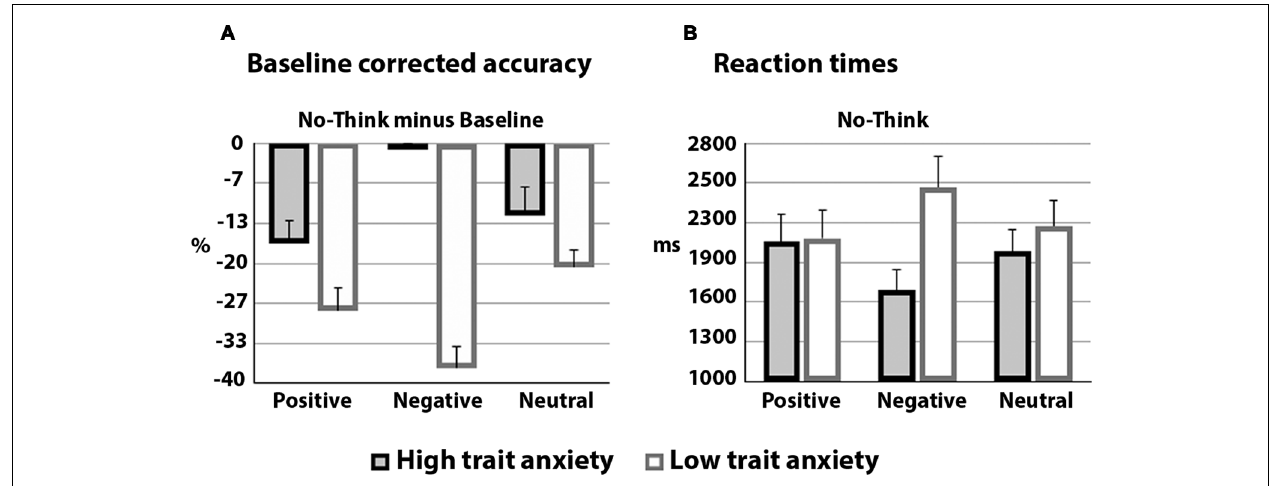
FIGURE 3 | (A) Mean recall percentages, for the no-think condition, of emotional scenes (positive, negative, and neutral) as a function of low or high trait anxiety. (B) Mean reaction times for correctly recalled negative, positive or neutral scenes in the no-think condition, as a function of low or high trait anxiety.